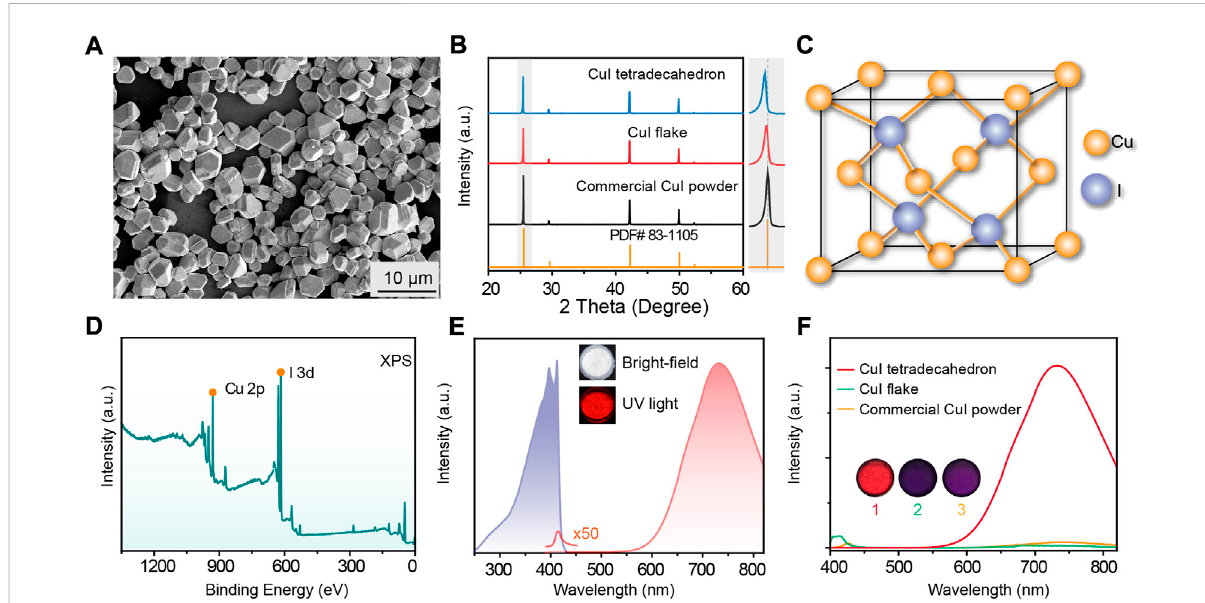
FIGURE 1 ( A) SEM image of the as-prepared CuI microcrystals. (B) XRD spectra of the as-prepared CuI microcrystals, CuI nano fl akes, commercial CuI powder, and standard CuI PDF card. (C) Simpli fi ed crystal structural model of the as-prepared CuI microcrystals. (D) XPS of the as-prepared CuI microcrystals. (E) Excitationspectrum(purple)andemissionspectrum(red)oftheas-preparedCuImicrocrystals.InsetimagesarephotographofCuI microcrystals power under bright- fi eld and UV excitation, respectively. (F) Comparison of fl uorescence emission spectra of different